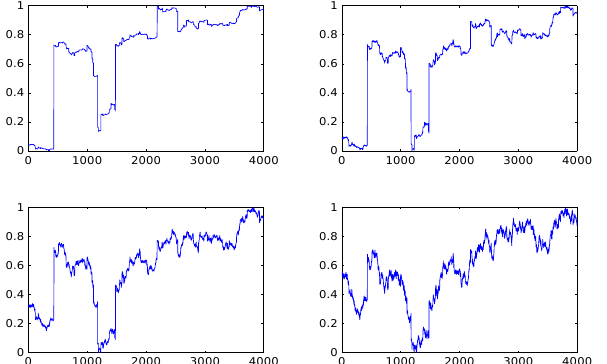
Fig. 14. Four stable motions with decreasing intensity of jumps. Top left: α = 1, top right: α = 1 . 3, bottom left: α = 1 . 7, bottom right: Fig. 15. Four stable motions with decreasing intensity of jumps. α = 1 . 9. Top left: α = 1 , top right: α = 1 . 3 , bottom left: α = 1 . 7 , bottom right: α = 1 . 9 .